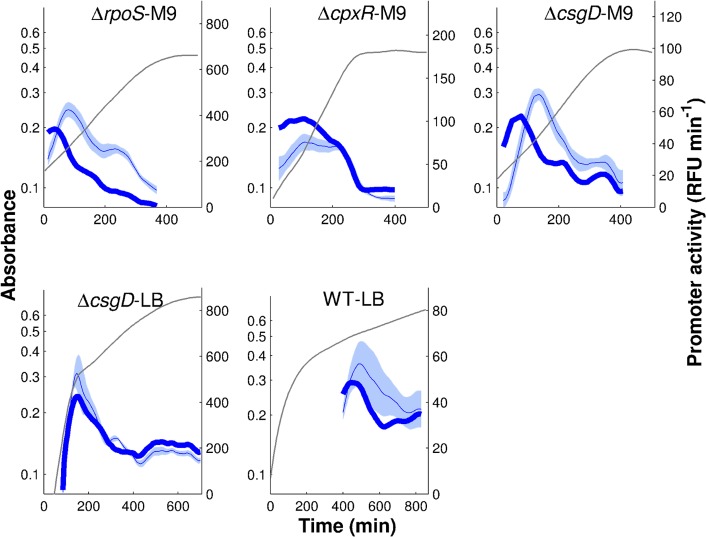
Regulation function of tar fitted to reporter gene data when replacing protein concentrations by promoter activities.The regulation function of Eqs. 1–2 was fitted using the promoter activities for tar, fliA, and flgM shown in Fig. 3, where the latter two replace the concentrations of FliA and FlgM, respectively. Model predictions are in dark blue (thick solid line), tar reporter data are in light blue (thin solid line and shaded area). The parameters were estimated using a multistart global optimization algorithm (see Methods and materials for details). The best fit returns the value Q = 33.4 for the objective function, for the parameter vector (k
0,k
1,n,θ,K) = (7.6,853,1,663,14615). Confidence intervals for the parameter values are reported in Text S10.